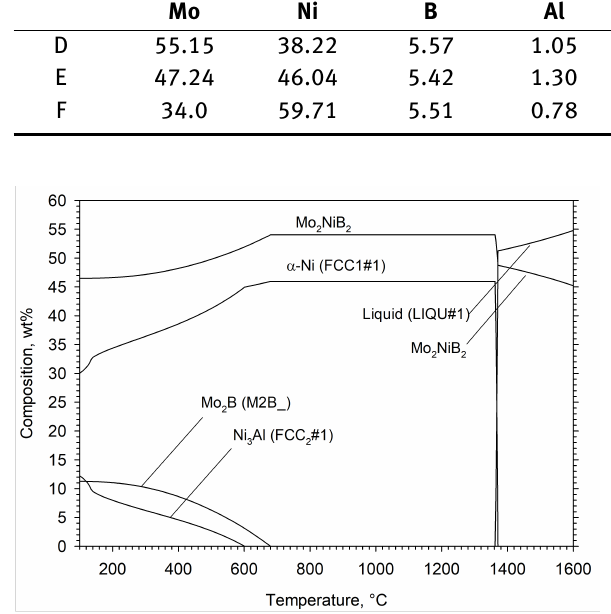
Figure 3: FactSage calculation of a selected SHS alloy for equilib- rium solidification (50% Ni, 44% Mo, 4% B, and 2 wt% Al, by mass)